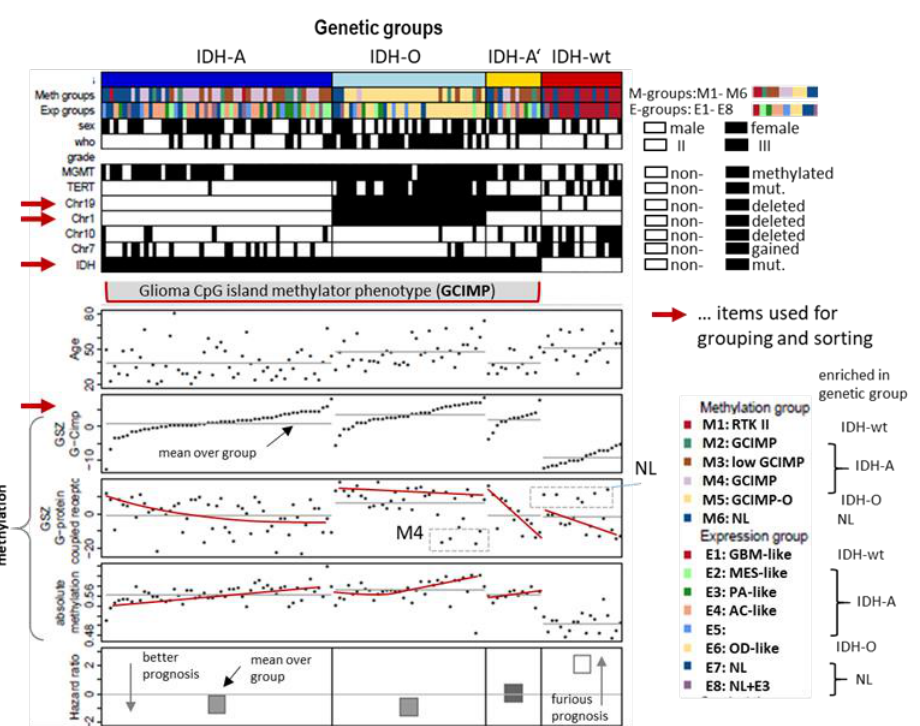
Figure 2. Genetic stratification of LGG, patient, genetic, and methylation characteristics. LGG were classified according to their IDH mutation status ( IDH -mutated tumours were subsumed as GCIMP) and the co-deletion status of Chr.1p/19q, and single deletion of Chr.19q and sorted in each of the groups with increasing GCIMP-methylation score [37]. Selected features such as TERT promoter mutation, CNV of Chr.7+ (gains) and Chr.10- (loss), WHO grade (II or III), and prognosis (hazard ratio) differ between the genetic groups. Expression (E1–E8) and methylation (M1–M6) groups as defined in [35] enrich in different genetic groups. The red lines serve as guide for the eye to show trends of GCIMP and G-protein coupled receptor (GPCR) DNA